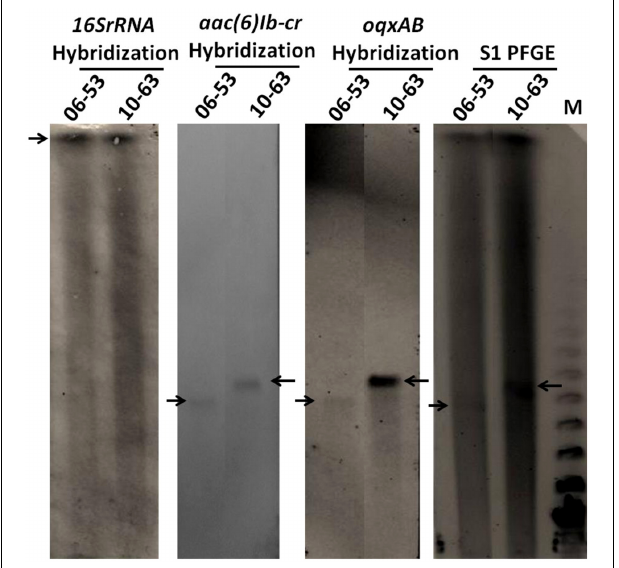
FIGURE 1 | S1-PFGE and southern hybridization of 16SrRNA, oqxA , and aac(6 (cid:2) )Ib-cr on two oqxAB-positive isolates. Arrows indicated chromosomal DNA or plasmids harboring oqxAB and aac(6 (cid:2) )Ib-cr . 06–53 and 10–63 are oqxAB -positive S. typhimurium clinical isolates; M, Lambda PFGE